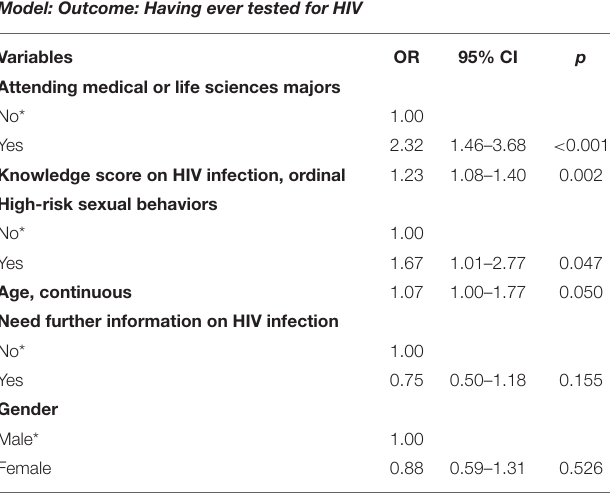
TABLE 3 | Results of the regression model for potential determinants of having ever tested for HIV. Model: Outcome: Having ever tested for